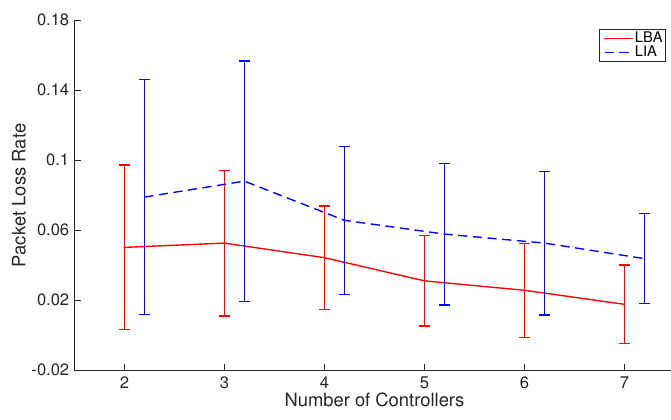
Figure 7. Loss rate with different number of